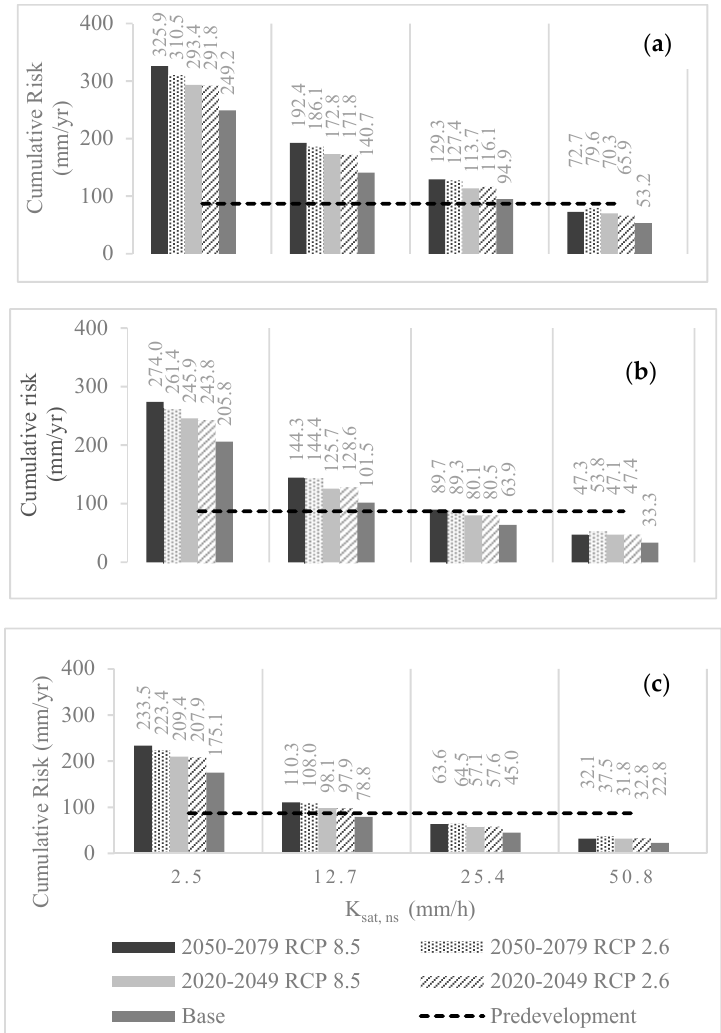
area under near-term projections, and 210 mm (195 m 3 ) to 2310 mm (2148 m 3 ) additional overflow Figure 1. Cumulative overflow events for each climate scenario based on K sat, ns for bioinfiltration from the drainage area under long-term projections. facilities with: ( a ) 76 mm of ponding, ( b ) 152 cm of ponding, and ( c ) 229 mm of ponding.